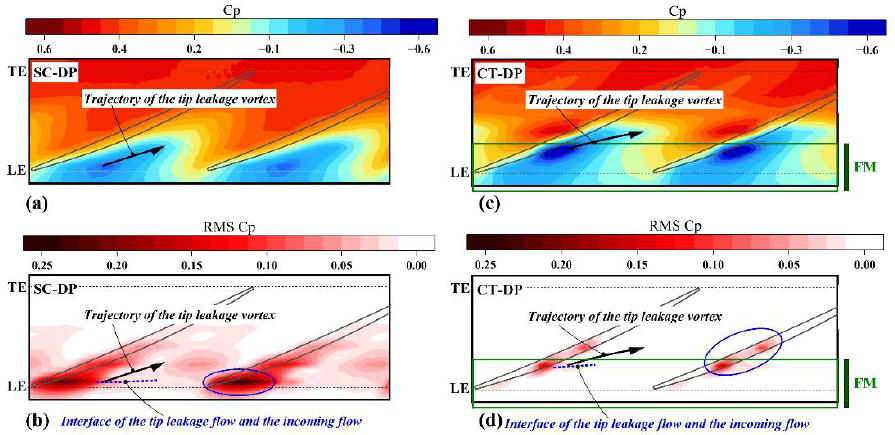
Figure 15. Comparison of tip flow structure of the compressor, with and without casing treatment, at DP. ( a ) C p contours with SC, ( b ) RMS C p contours with SC, ( c ) C p contours with CT, ( d ) RMS C p contours with CT